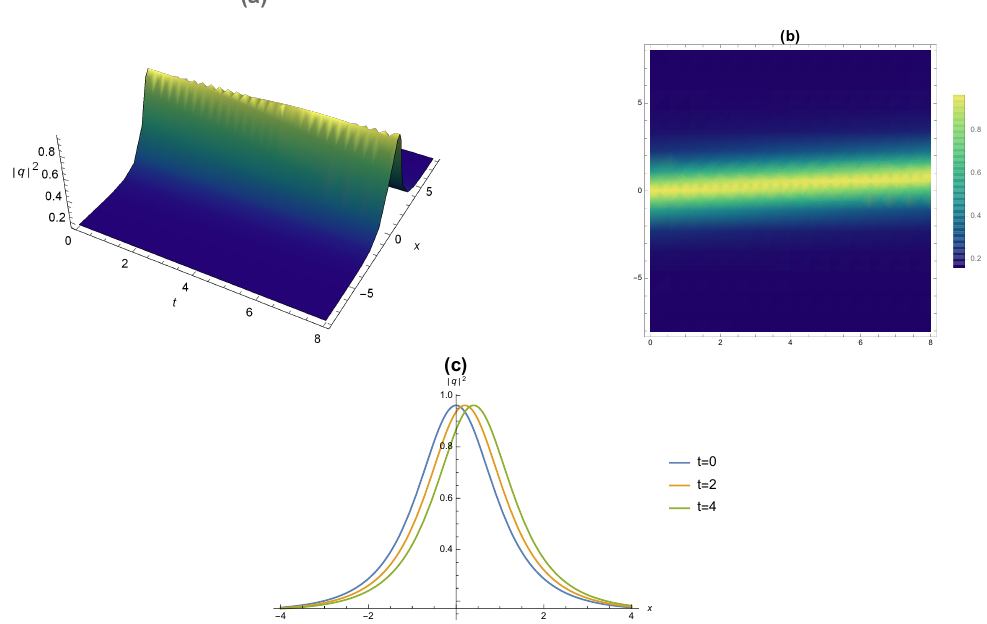
Figure 1. Represents a bright soliton solution (17) with appropriate values of parameters, n = 0.5; k =